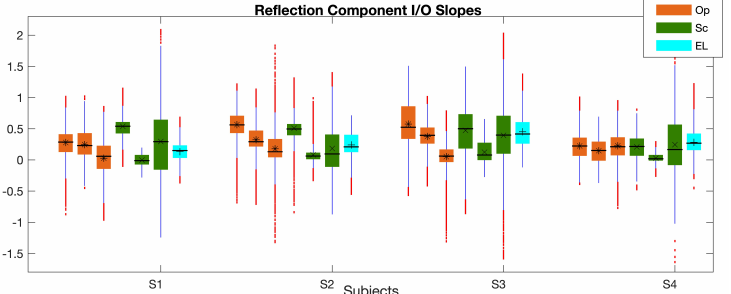
Figure 9. Boxplot of the I / O refl slopes at low, mid, and high L 2 s (three orange and green bars show the Op and Sc paradigms, respectively; the cyan bars show the mid-level values in the EL paradigm) across frequency. The central horizontal line, and the bottom and top edges of the boxes indicate the median, 25th and 75th percentiles, respectively. The averages of individual bars are indicated by the ∗ , × , + symbols (for the Op, Sc, and EL paradigms, respectively) inside the boxes. The whiskers extend to the most extreme data points and outliers are plotted using red dots. The subjects IDs (S1–S4) are indicated on the